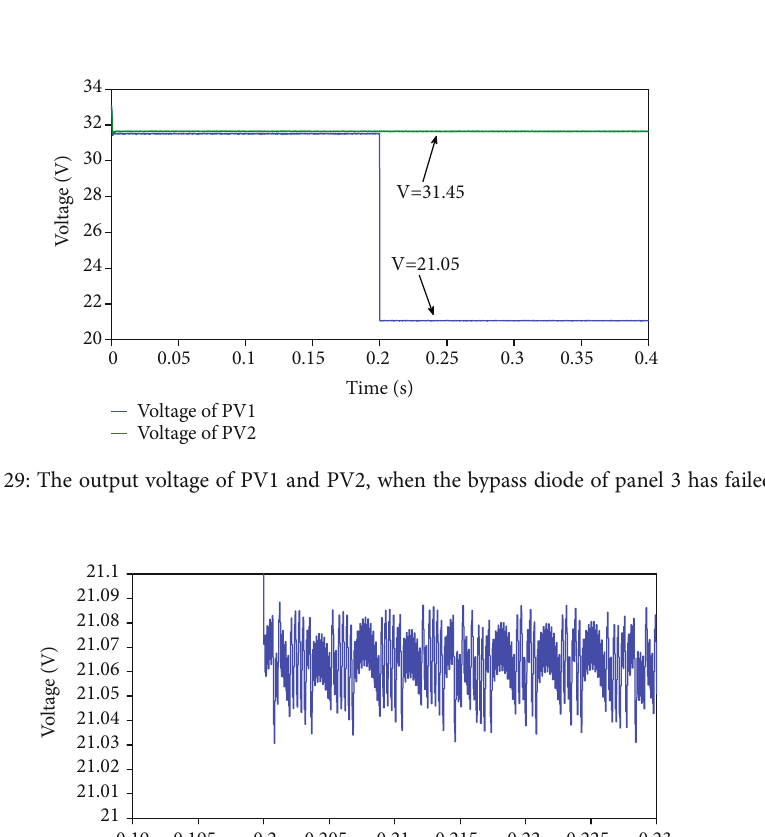
Figure 28: The output voltage of PV1, while one of panels ’ is failed.